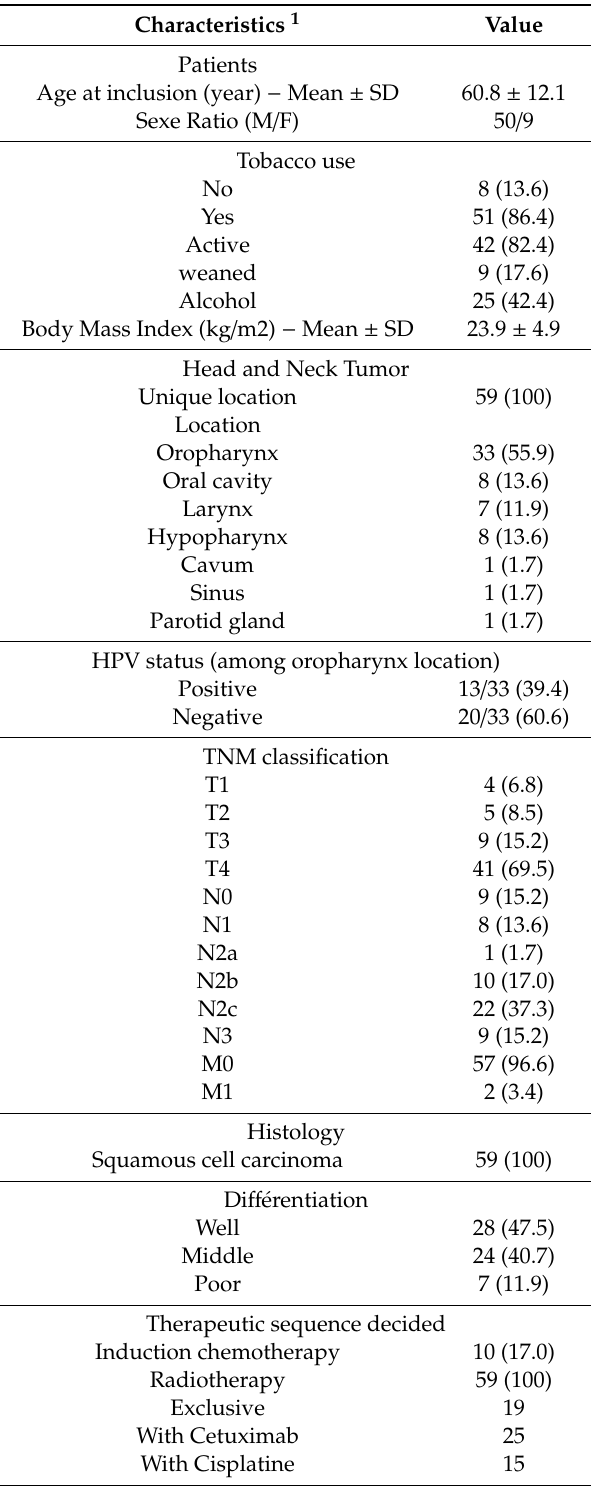
Baseline clinical characteristics of patients, characteristics of tumors and treatment modalities